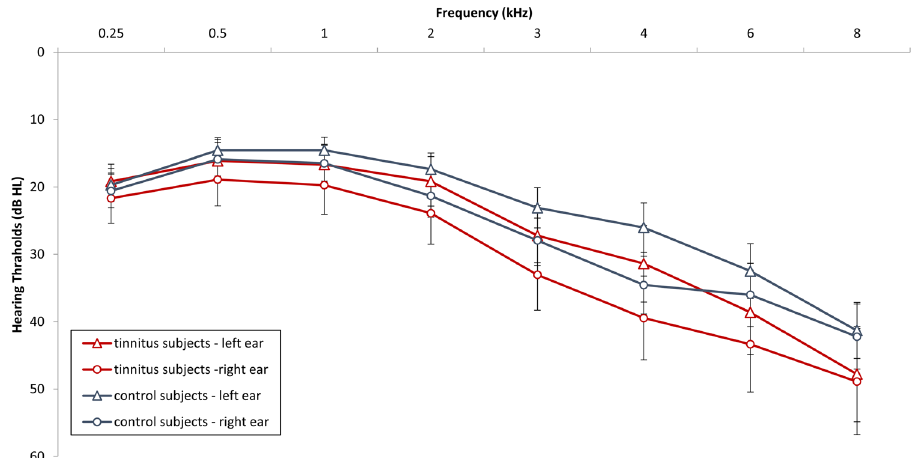
Figure 1. Auditory thresholds for the left and right ear for control subjects and tinnitus subjects. Both tinnitus and control groups had similar auditory thresholds when individual frequencies were